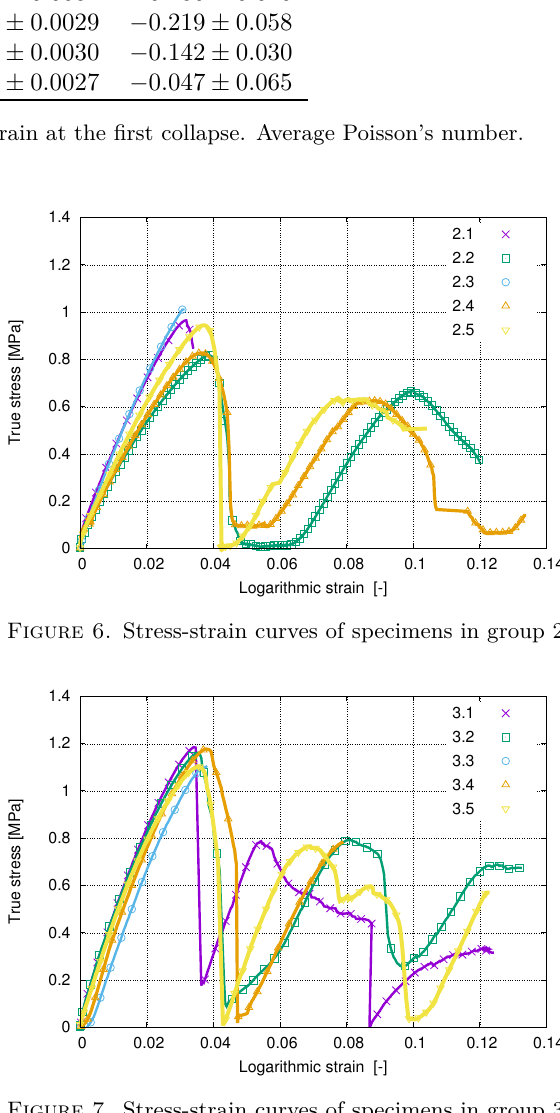
Figure 5. Stress-strain curves of specimens in group 1.